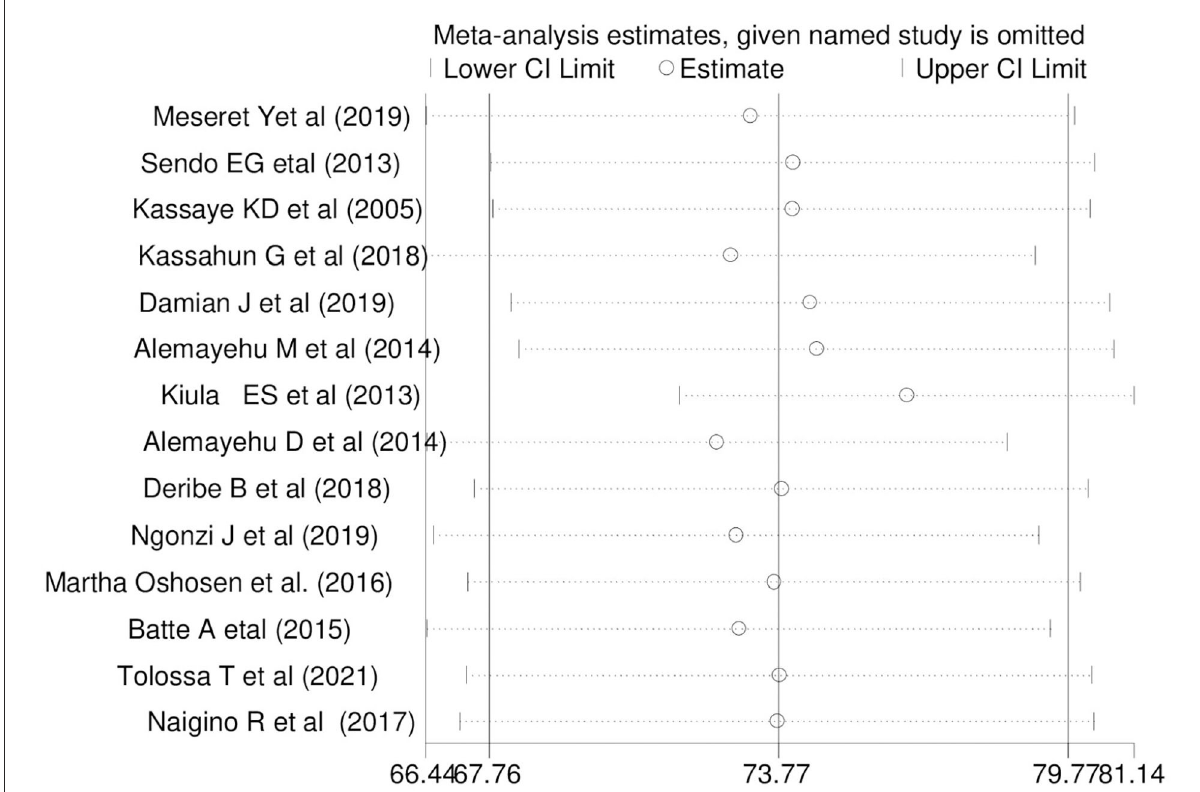
FIGURE5 Sensitivity analysis for single study influence of the pooled magnitude of HIV sero-status disclosure women in East Africa, 2021.